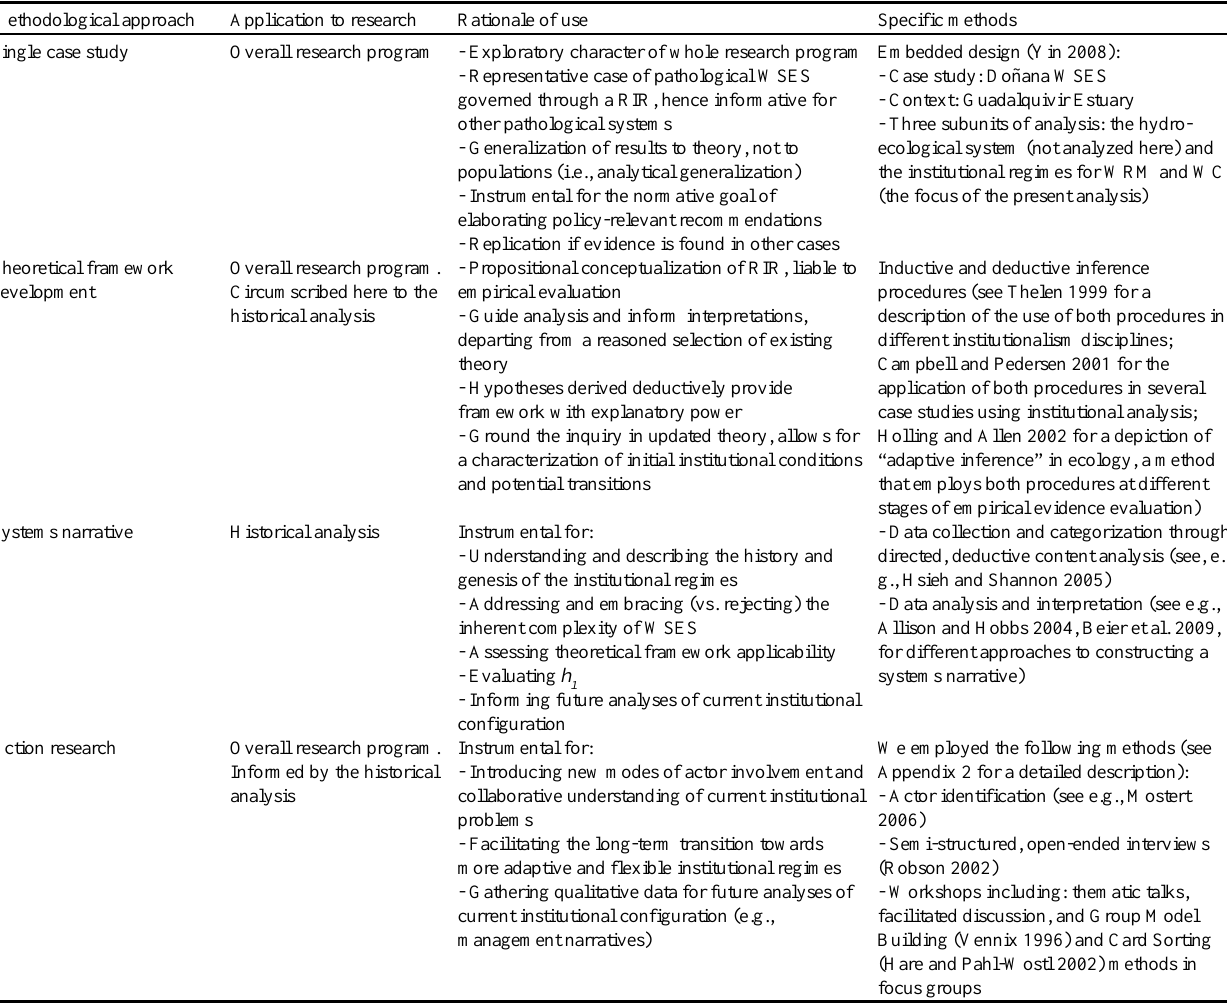
Table 1 . Summary of